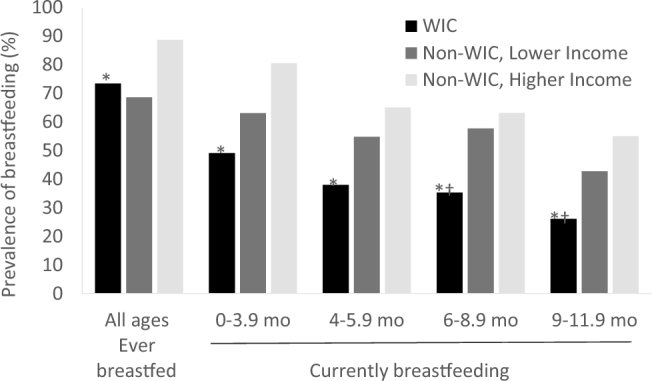
Percentage of mothers who ever breastfed or currently breastfeed infants ≤12 mo by WIC participation, from FITS 2016 feeding practices questionnaire. *WIC significantly different than higher-income (likely not WIC-eligible) nonparticipants, P < 0.05; †WIC significantly different than lower-income (likely WIC-eligible) nonparticipants, P < 0.05; based on Rao-Scott modified chi-square test. WIC, Special Supplemental Nutrition Program for Women, Infants, and Children.